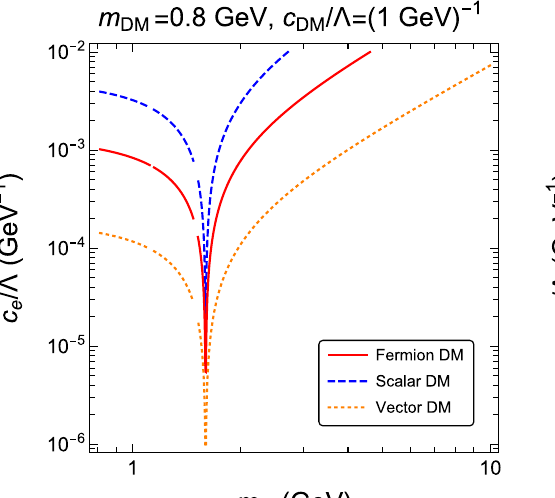
ter, respectively. We chose m DM = 0 . 8 , 1GeV on left and right plots, respectively, and c DM /(cid:3) = ( 1GeV ) − 1 for both